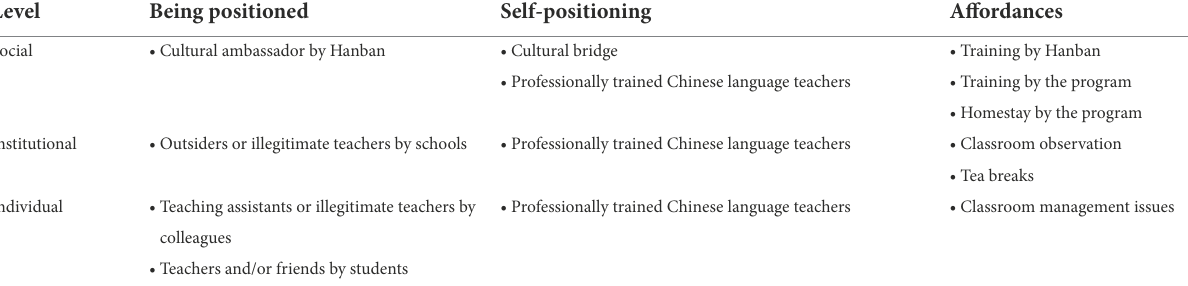
TABLE 2 Novice CFL teachers’ positioning and affordances in primary schools in New Zealand. Level Being